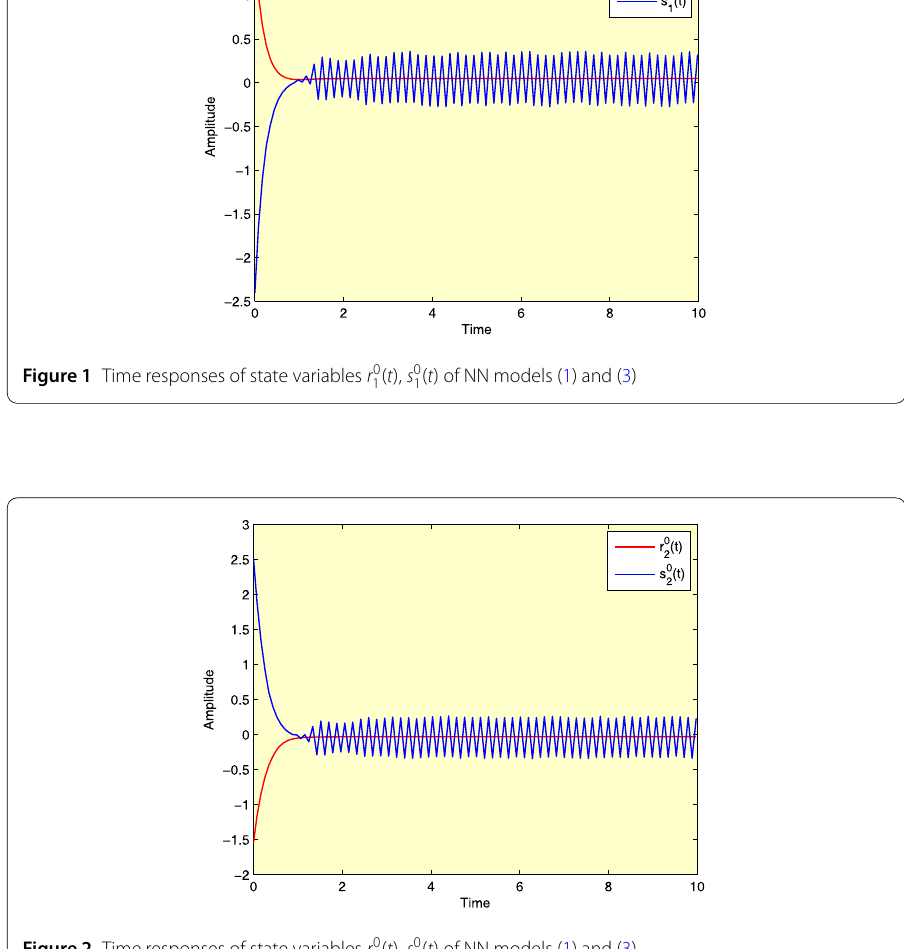
Figure 2 Time responses of state variables r 0 2 ( t ), s 0 2 ( t ) of NN models (1) and (3)